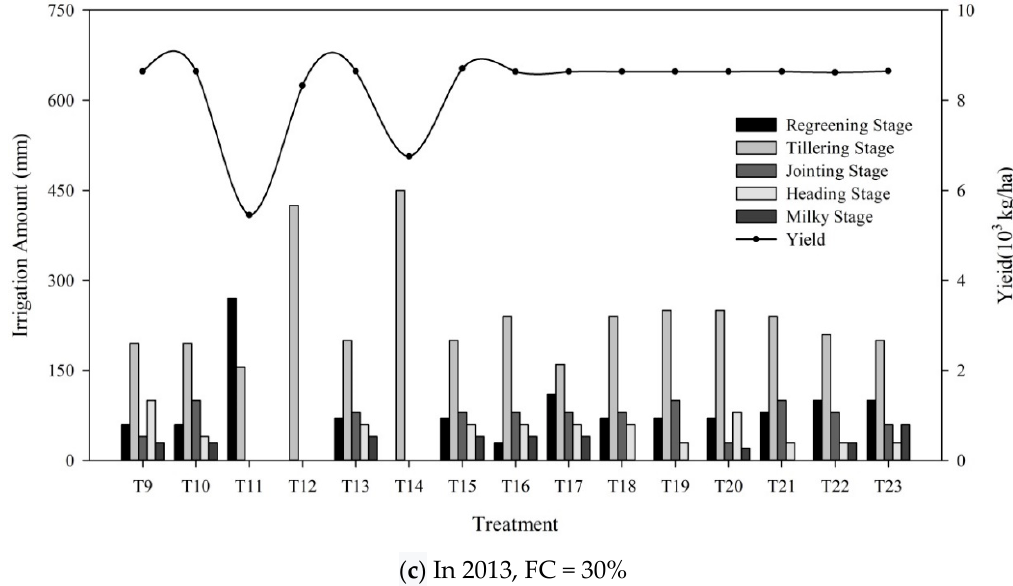
Figure 4. Relationship diagram of the irrigation amount and yield during the growth